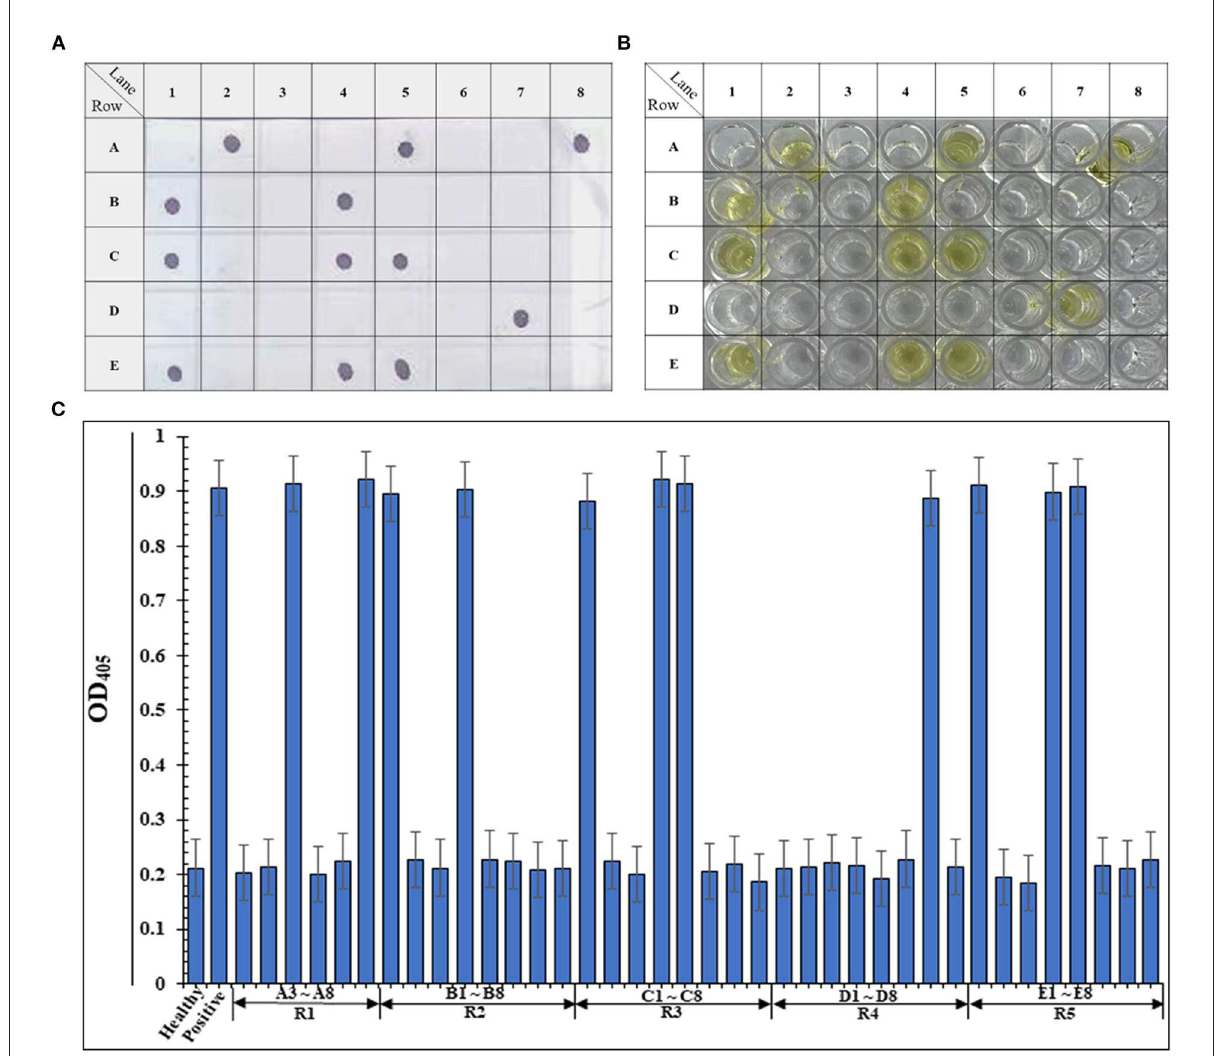
FIGURE5 Establishments of the high-throughput immuno-dot-blot assay and ELISA detections of ReMV for R. glutinosa field samples. (A) Immuno-dot-blot assay results of the 38 field samples that collected form Henan Province. The A1 represents the negative control, and the A2 stands for positive control. Samples that from A3–A8, B1–B8, C1–C8, D1–D8, and E1–E8 comprised the 38 R. glutinosa samples from Henan. (B) Pictures of the ELISA blank that show the same 38 samples from Henan. (C) ELISA absorbance (OD 405 ) readings of the 38 samples from (B) measured at a 405nm, and the histogram was mapped.